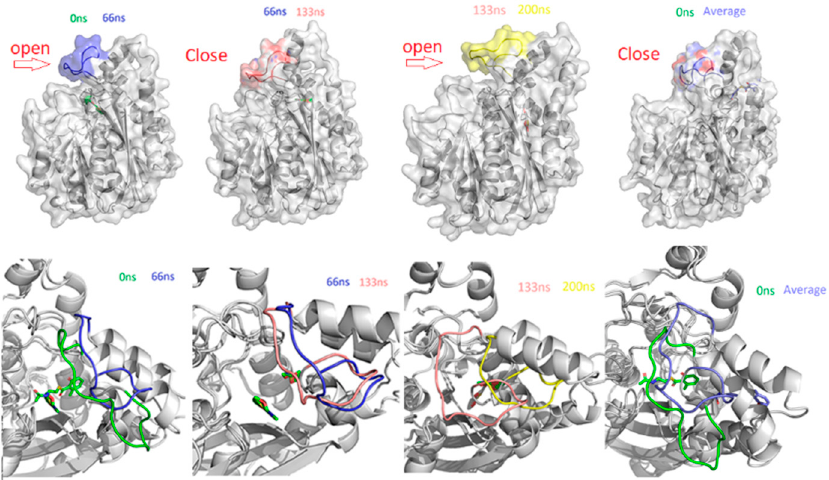
Figure 7. Represent the open and close state of protein in response to simulation. represent the variations captured during the simulation at different time intervals of 0 ns, 66 ns, 133 ns and 200 ns experienced by the 6MSA-SNAC complex. Each complex is shown in different colors. The substrate binding and the loop 196–211 are presented in different panels at a specific time point.